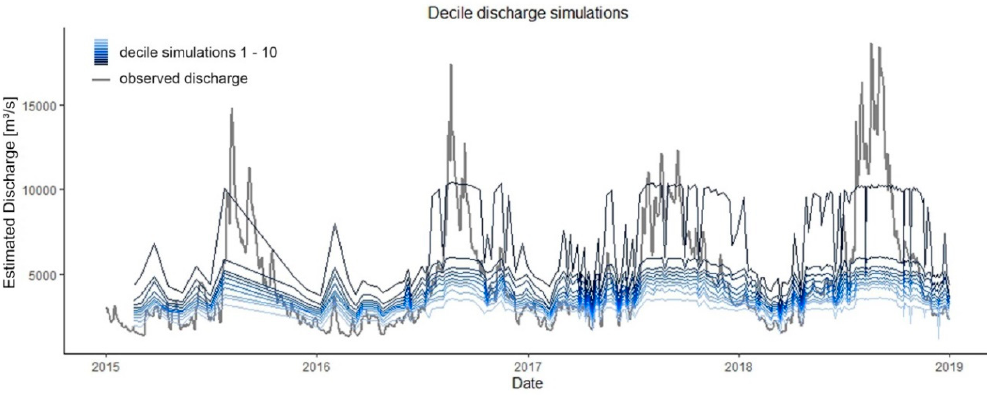
Figure 15. Decile simulations derived from all discharge simulations.